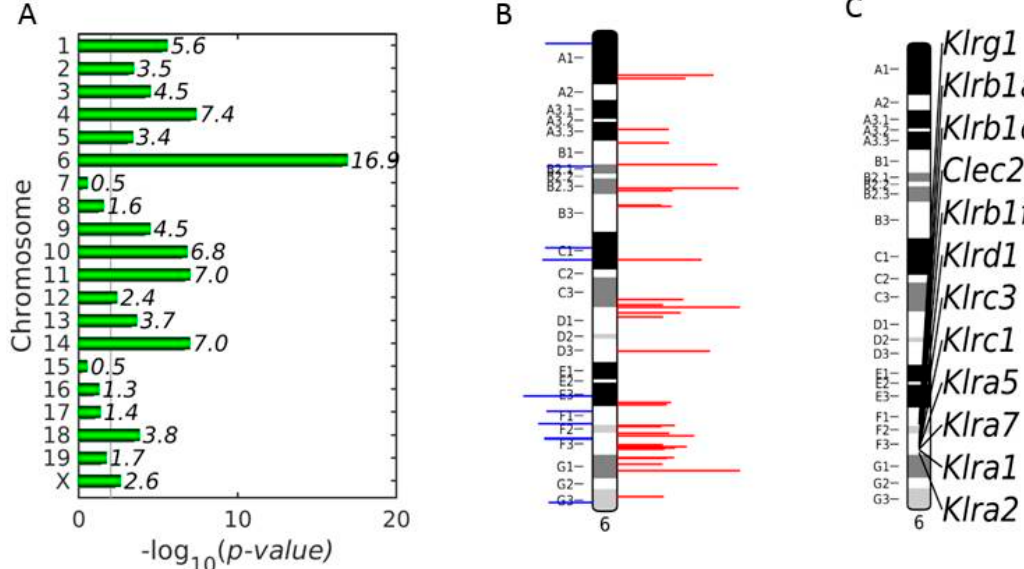
Figure 3. Chromosome landscape analysis of the differentially expressed genes (DEGs) in the liver between vaccinated and non-vaccinated mice on day 4 p.i. ( A )–log 10 ( p -value) of the enrichment of each chromosome with up-regulated DEGs in the vaccinated population in relation to the non-vaccinated one on day 4 p.i . The most enriched chromosome is the chromosome 6. ( B ) Ideogram of chromosome 6 with all DEGs in the vaccinated population in relation to the non-vaccinated one on day 4 p.i . The horizontal blue and red lines mark the loci of the down- and up-regulated DEGs, respectively, and their lengths are proportional to the average level of expression. ( C ) Ideogram of chromosome 6 with the uni-dimensional clustering of the up-regulated DEGs in vaccinated mice in relation to non-vaccinated mice on day 4 p.i . The natural killer cell complex (NKC) is localized in the F3 cytoband and its up-regulated DEGs are shown on the right.